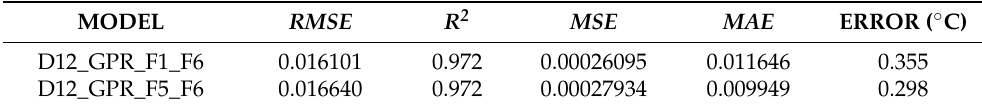
Table 7. D12 Validation Results for F1–F6 and F5, F6 Model Inputs.